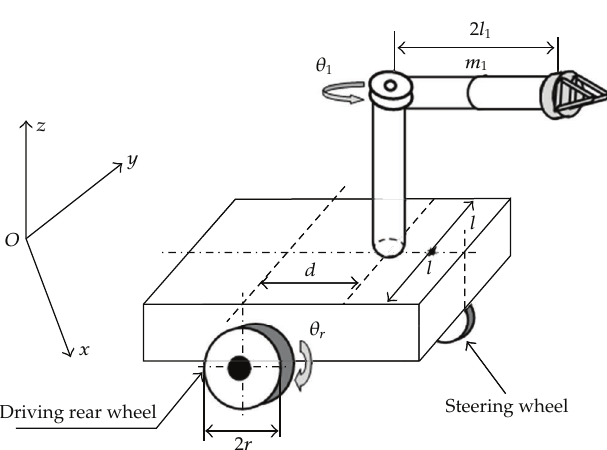
Figure 2: The wheeled mobile manipulator in the